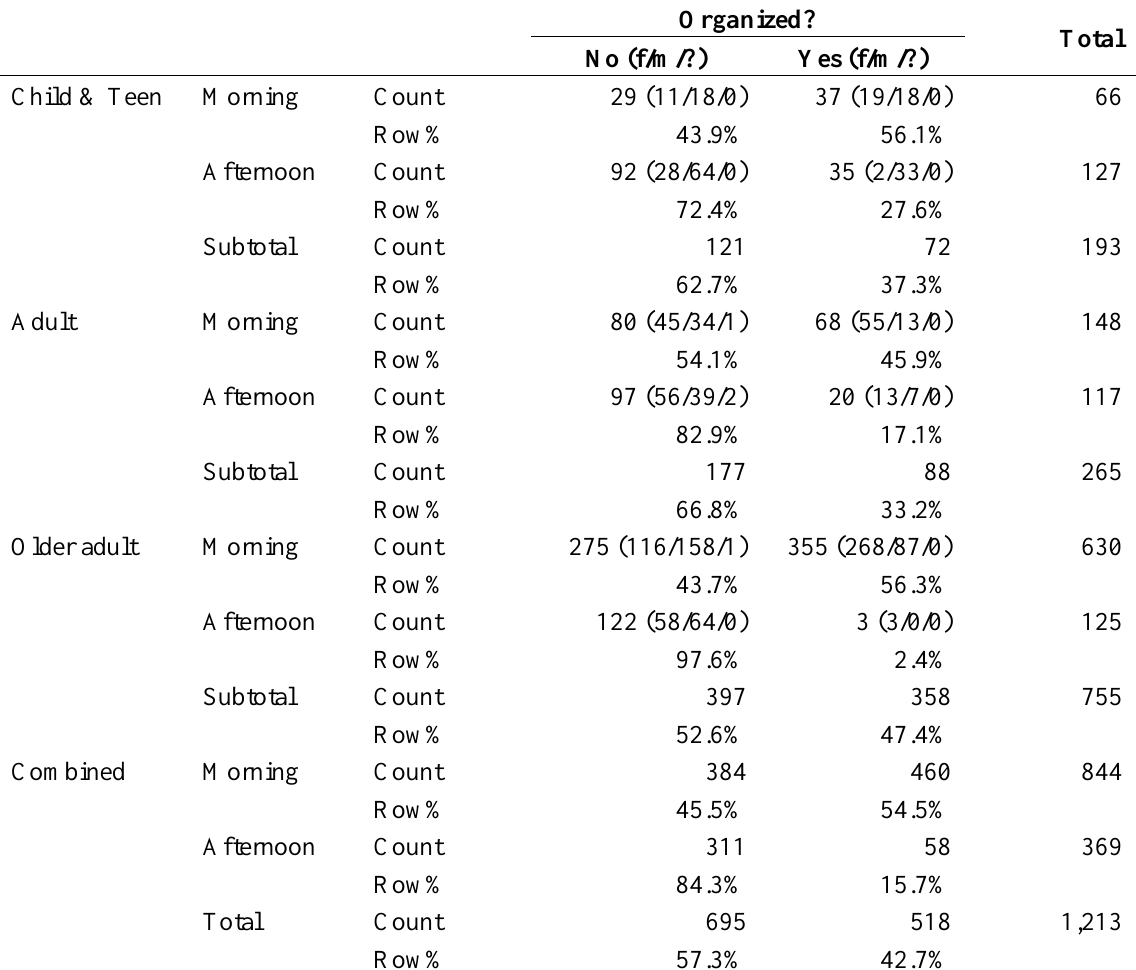
Table 5. Organized and unstructured activity by age group, gender, and time of day.